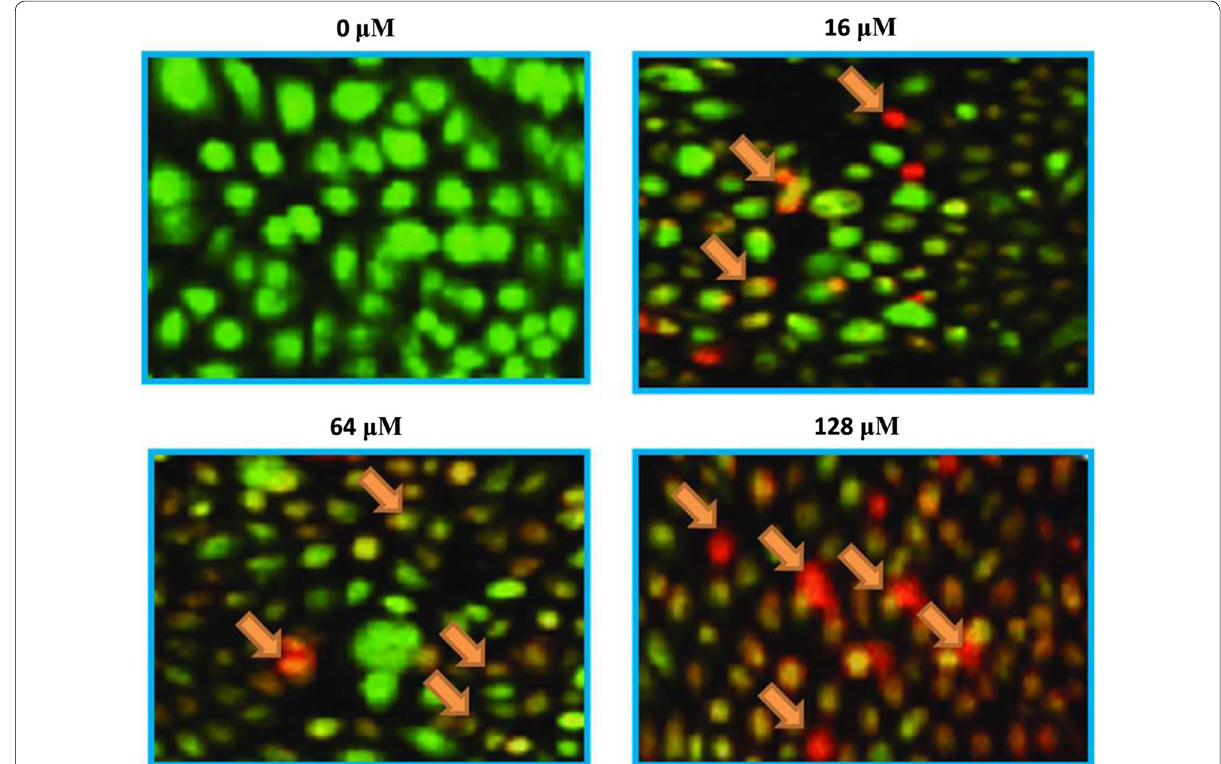
Fig. 5 Apoptosis assessment via AO/EB staining assay representing the early, late apoptotic and necrotic cell percentage after HeLa cells were subjected to garcinone-E exposure. Individual separate experiments were implemented three times